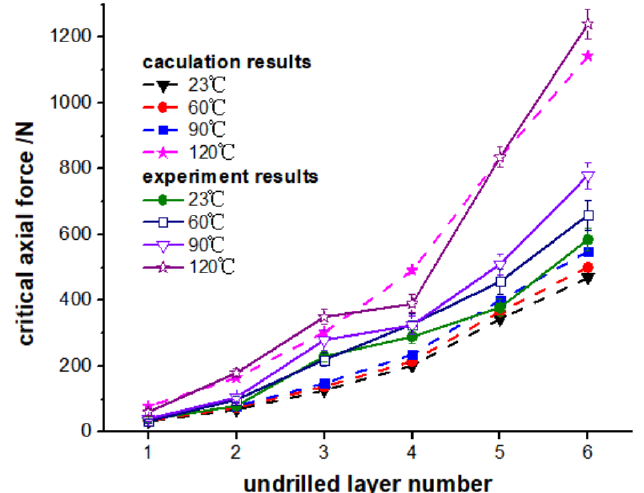
Figure 14. Comparison of the theoretical and experimental solutions of critical axial force.